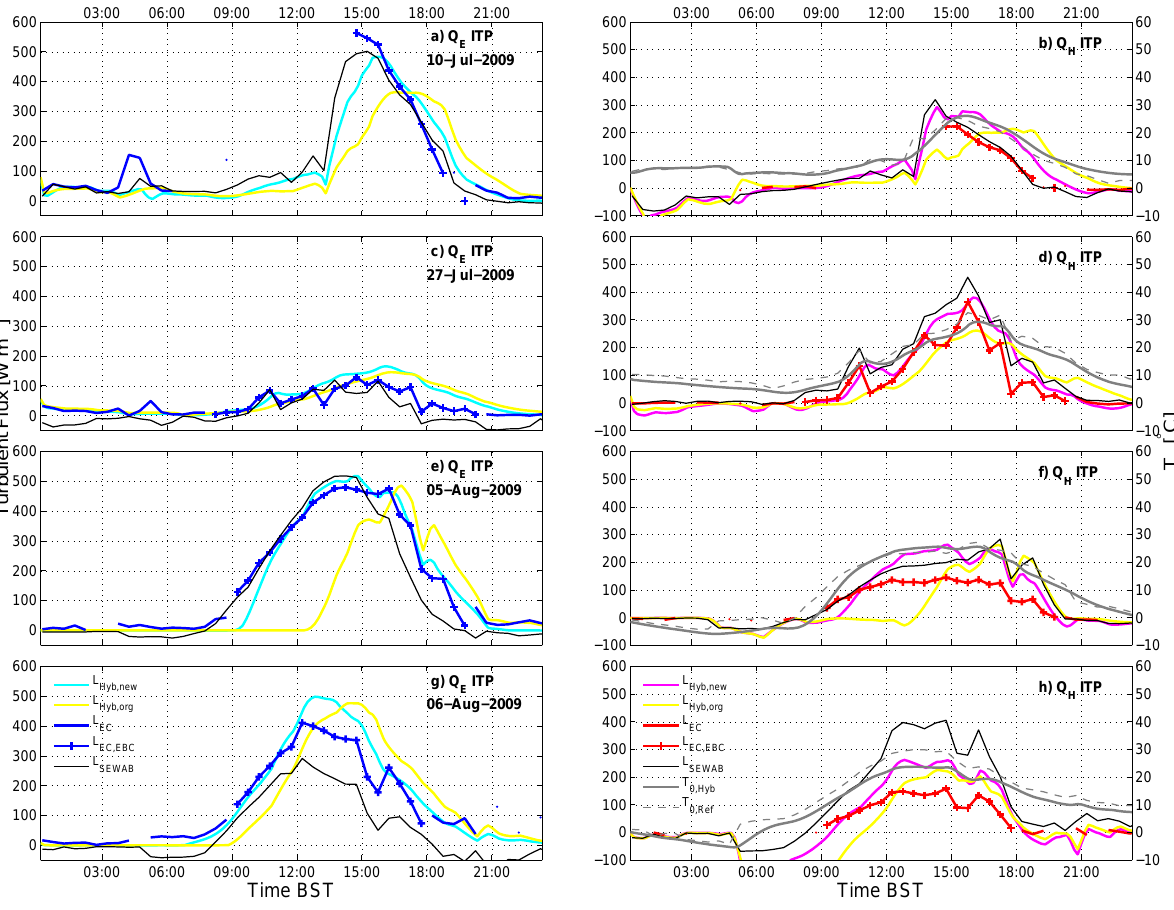
Fig. 7. Same as Fig. 6, but for ITP. There are no contributions from the